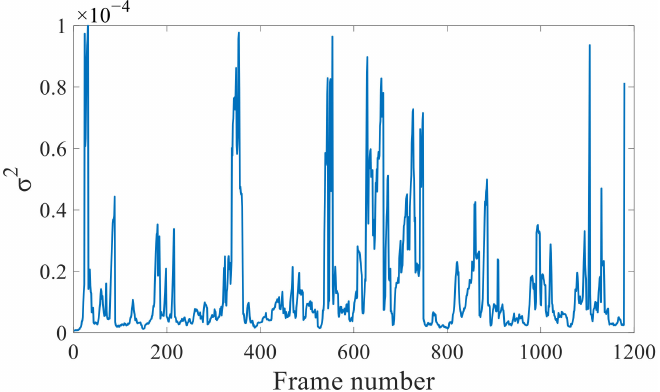
Figure 6. Unit-weight RMSEs of the visual reprojection without re-optimization.